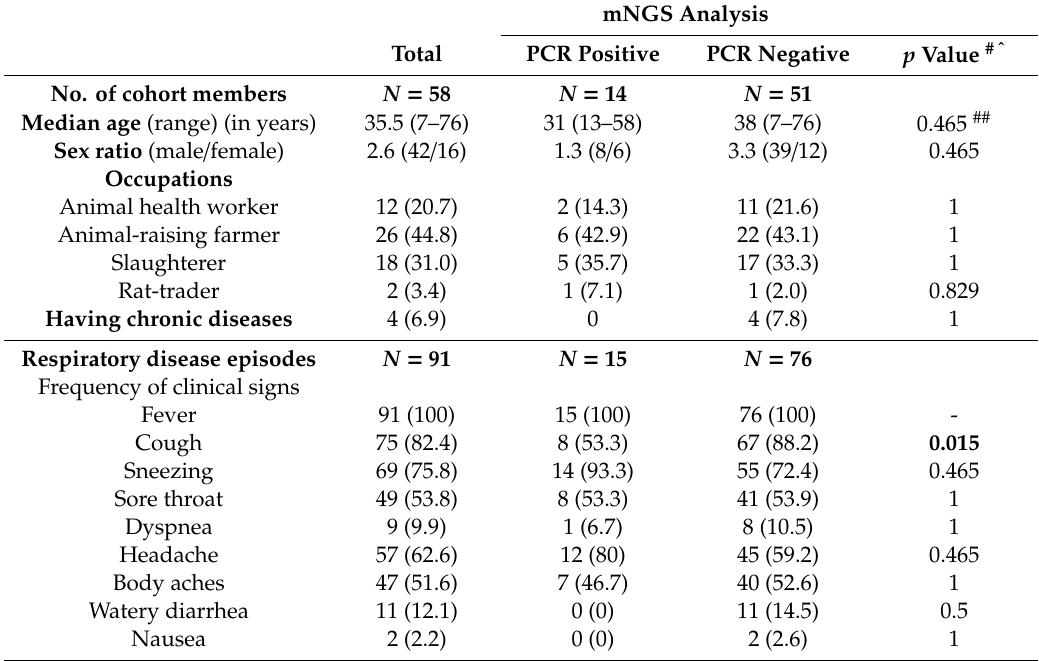
Table 1. General characteristics of the 58 cohort members, and comparison between clinical symptoms recorded at respiratory-disease episodes of PCR-positive and -negative